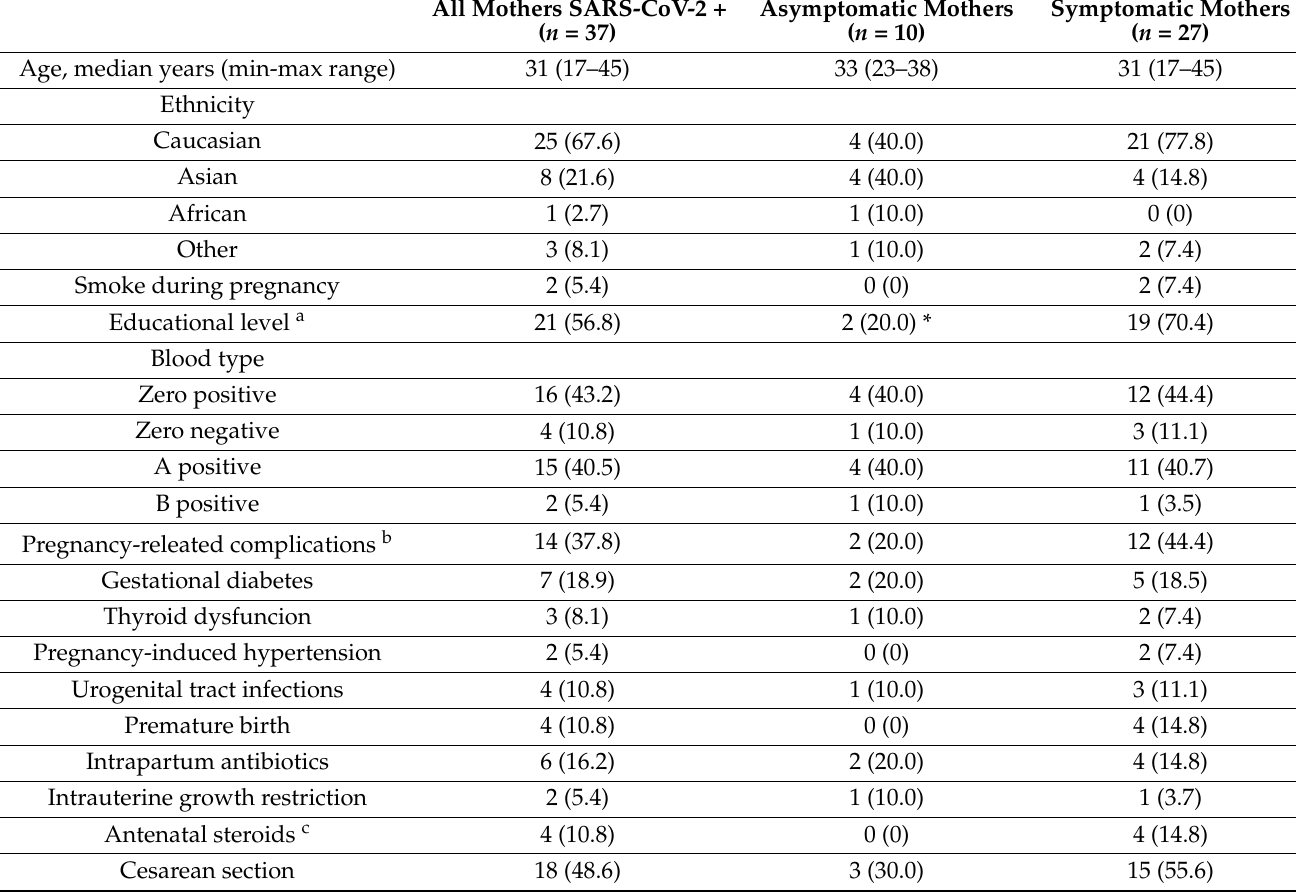
Table 1. Demographics and clinical characteristics of mothers with confirmed infection by SARS-CoV-2 at the delivery.